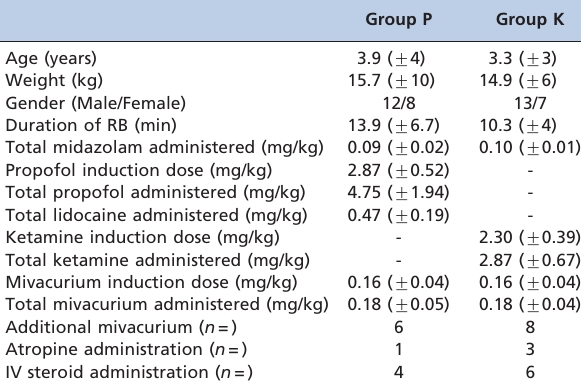
Table 3 - Hemodynamic